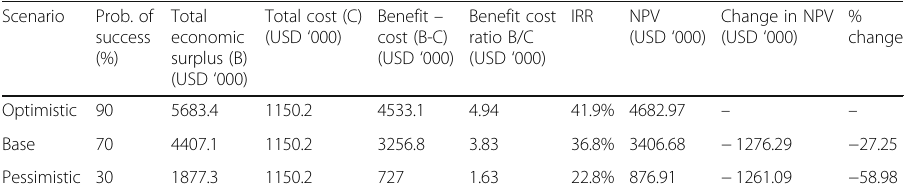
Table 6 Probability of success sensitivity analysis